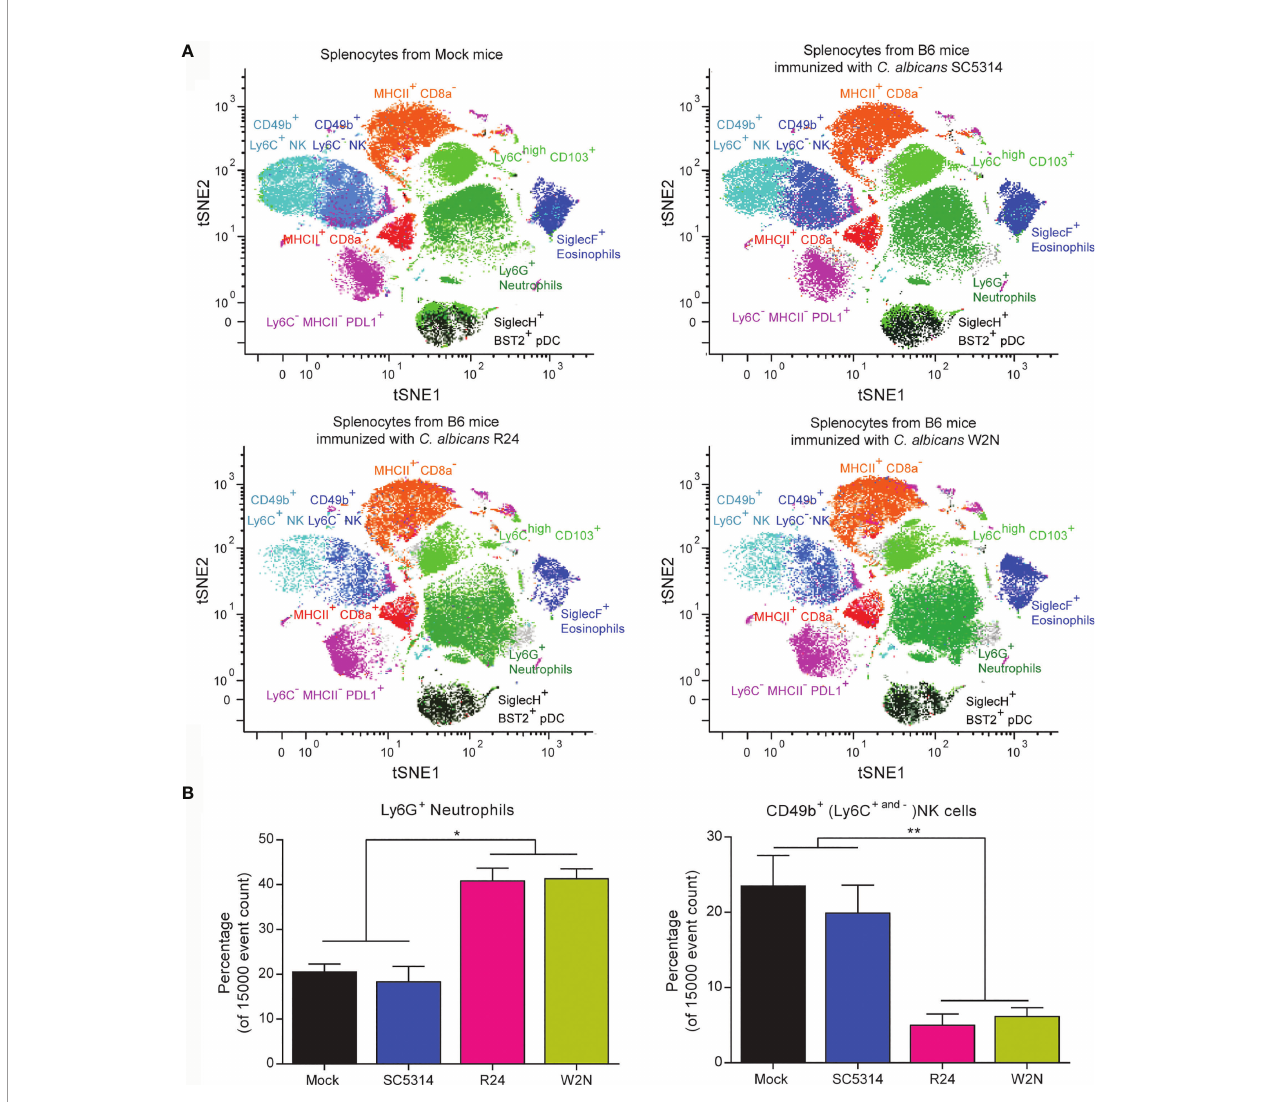
FIGURE 2 | Cytometry by Time-Of-Flight (CyTOF) analysis of splenocytes from mice vaccinated with the evolved strains R24 and W2N identi fi es multiple changes in the innate immunity populations. (A) tSNE plots of CD45 + CD90 − CD3 − CD19 − myeloid spleen cells from non-vaccinated mice and mice vaccinated with a low dose of the wild-type C. albicans strain SC5314 (10 4 CFUs/mouse) or with the evolved C. albicans strains R24 and W2N (5x10 5 CFUs/mouse) illustrating color-coded cell populations that clustered based on cell surface marker expression. (B) Bar graphs show the mean ± SEM of the Neutrophils and NK populations in the splenocytes from vaccinated and non-vaccinated mice. n=3 mice/group. One-way ANOVA with multiple comparisons (ANOVA p-value of 0.0002 for neutrophils and 0.0031 for NK cells), ** P < 0.01, * P <